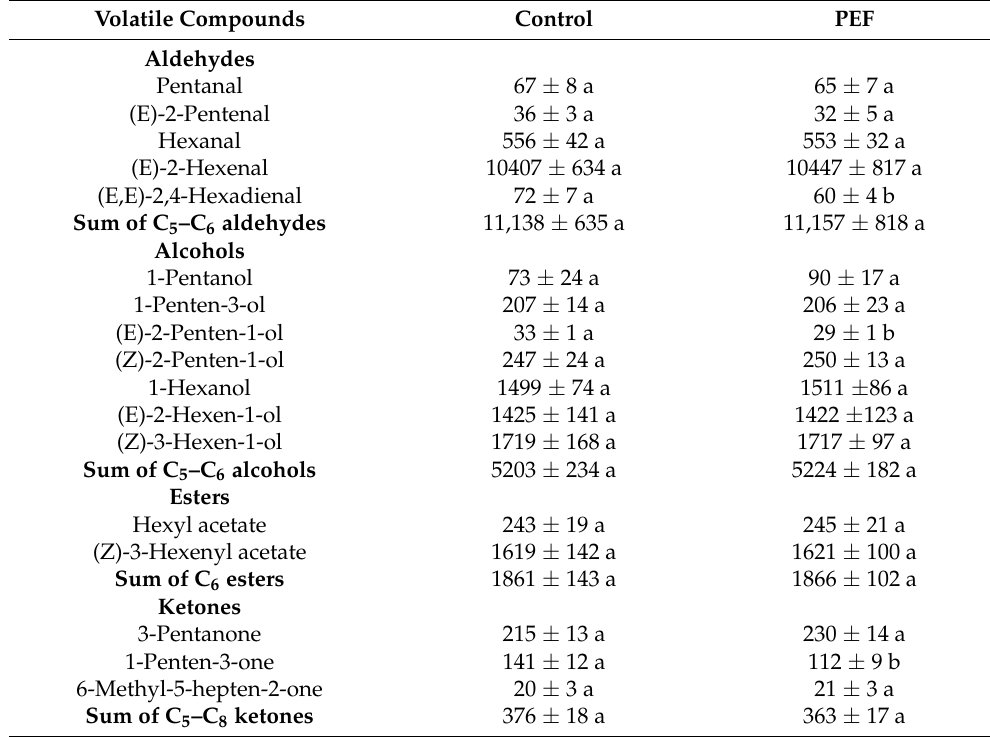
Table 5. Volatile compounds detected in EVOOs. Data expressed as µ g kg − 1 . Volatile